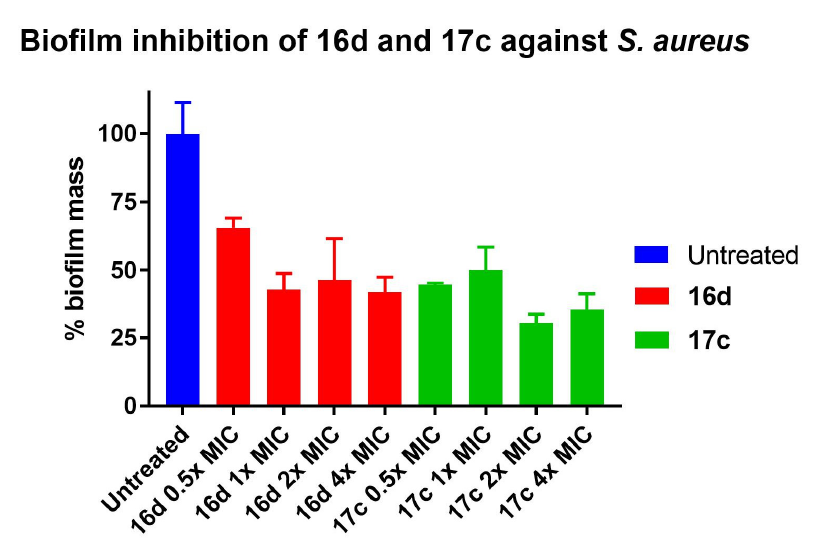
Figure 5. Inhibition of biofilm fomration of S. aureus by peptidomimetics 16d and 17c at 0.5×, 1×, 2× and 4× MIC. Error bars represent the standard error of triplicates ( n = 3).